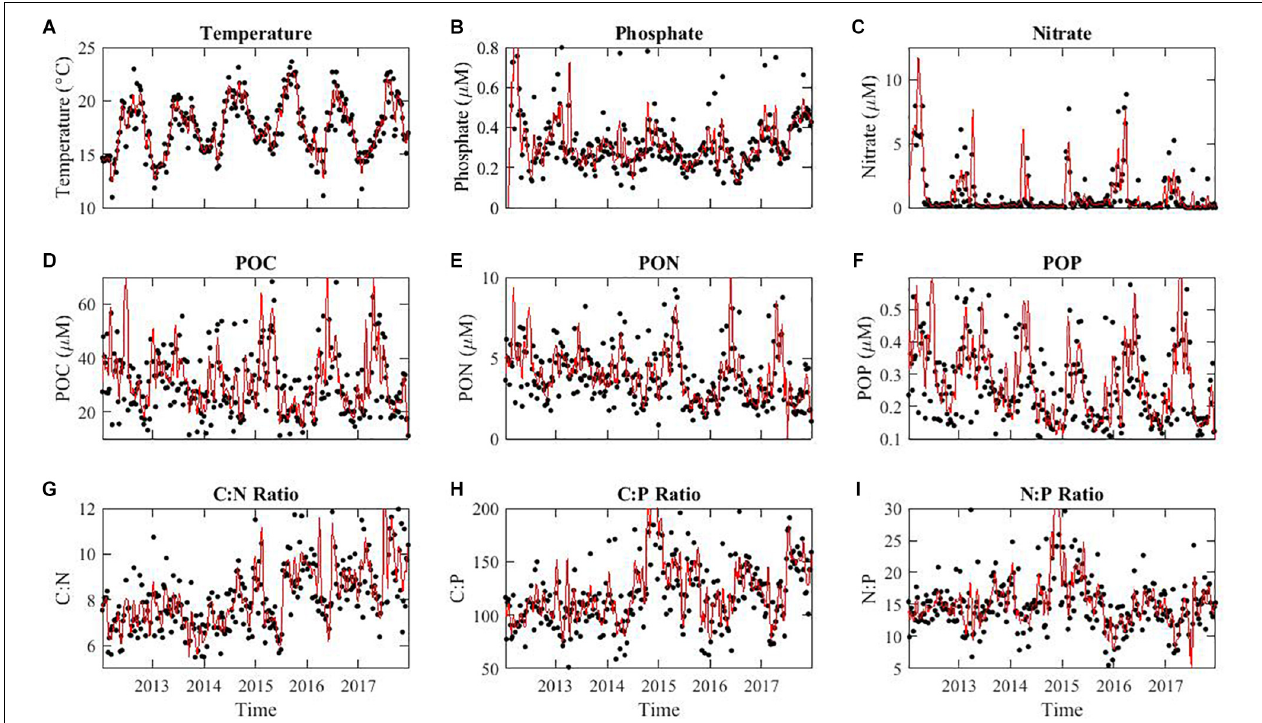
FIGURE 2 | Environmental conditions (A) , macronutrient concentrations (B,C) , POM concentrations (D–F) , and elemental stoichiometric ratios (G–I) over time at MICRO study site in Newport Pier, Newport, CA. The solid black points represent the averaged data per week from the period of 1/1/2012 to 12/31/2017. The red line represents a 4-point moving average. Stoichiometric ratios are molar.